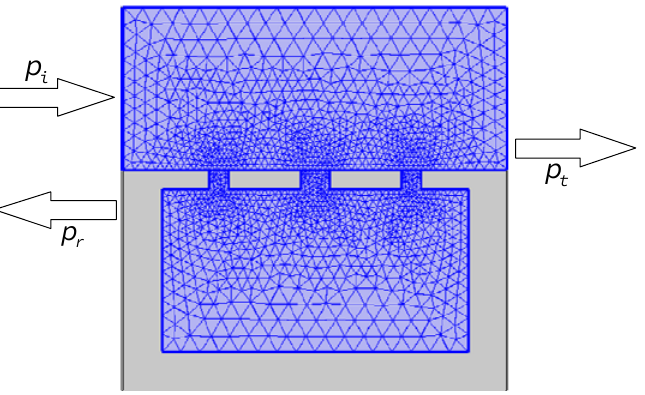
Figure 3. COMSOL acoustic finite element model (FEM) of the DHR device with two leak holes.